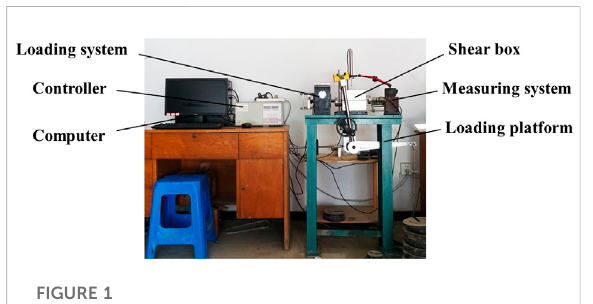
FIGURE 1 Direct shear apparatus for rock joint with weak interlayer.